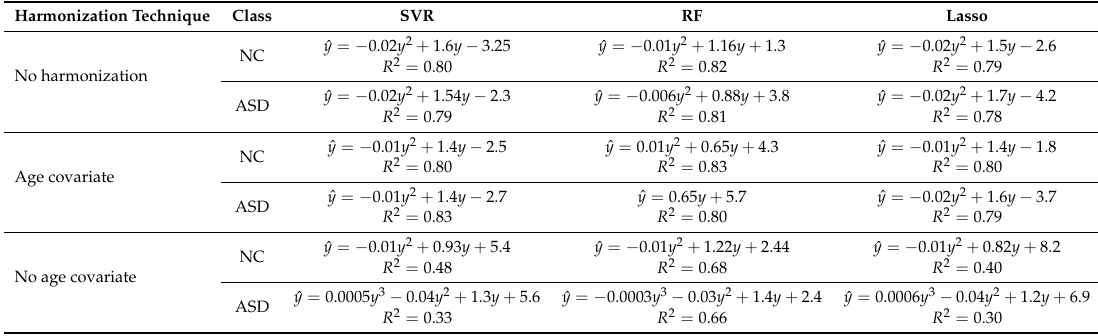
Table 4. Best-fitting models of age prediction and adjusted R 2 for each class and each harmonization technique for the three regression algorithms SVR, Random Forest and